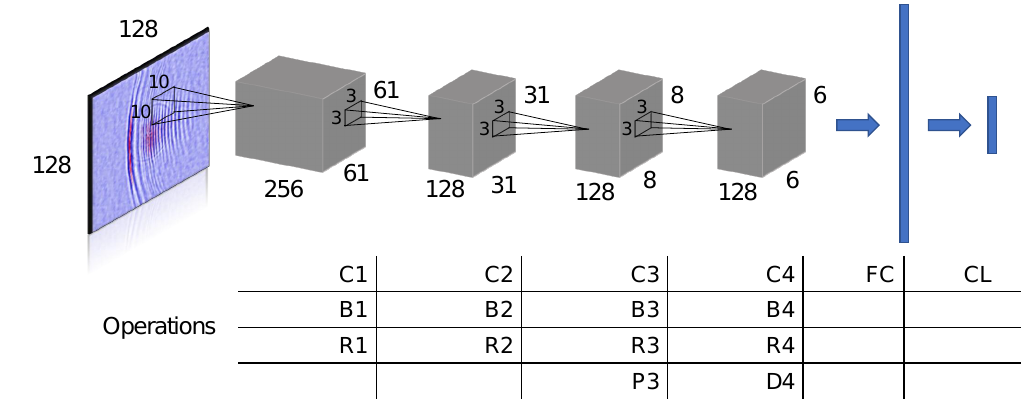
Figure 4. The proposed USseqNet